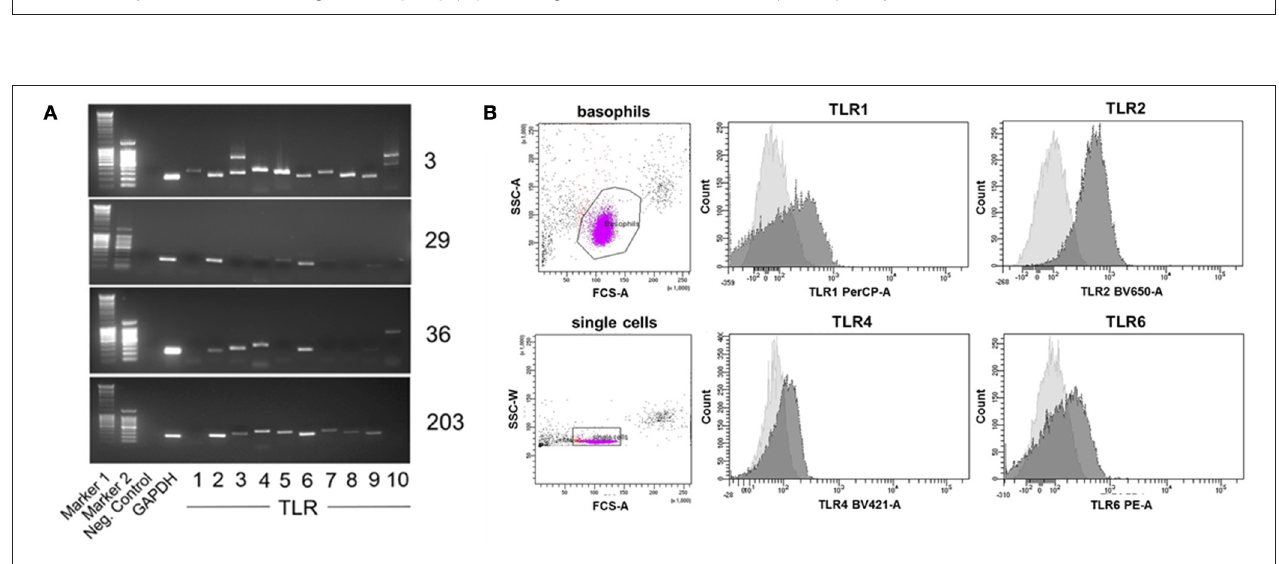
FIGURE 7 | Individual TLR expression on human basophils as assessed by RT-PCR and surface staining followed by flow cytometry. (A) Expression of TLR1 − 10 cDNA as assessed by RT-PCR of four individual donors shown as an example for distinct expression patterns. The full set of donors are listed in Table 2 . (B) Expression of the surface-exposed TLR1, 2, 4, and 6 on basophils of donor 29 measured by flow cytometry. Depicted are the histogram overlays of unstained (light gray) and with the respective fluorescently-labeled antibody stained (dark gray) basophils.